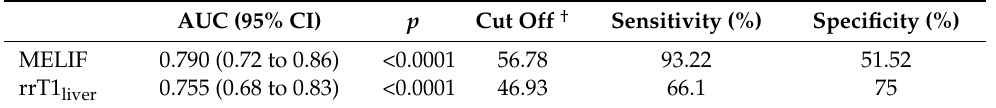
performance (0.75). Table 3. AUC analysis of the MELIF score and rrT1 liver score with corresponding sensitivity and specificity values to distinguish patients with normal (MELD ≤ 10) and impaired liver function (MELD